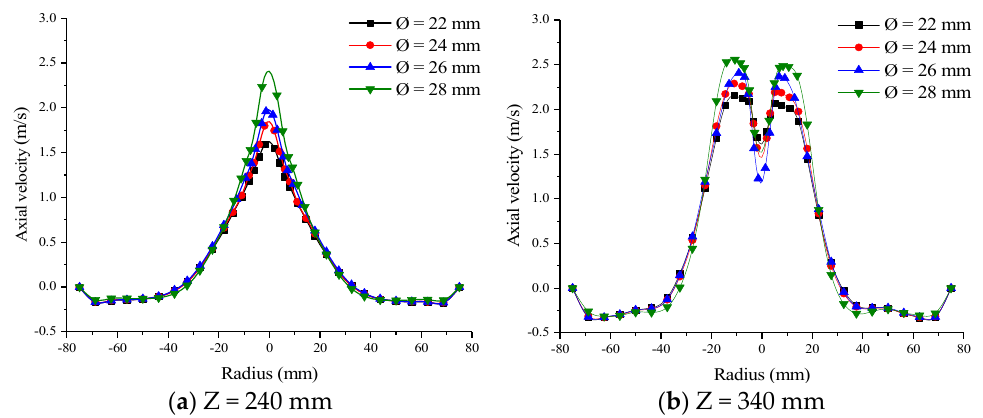
Figure 4. Axial velocity distributions for different internal vortex finder diameter.